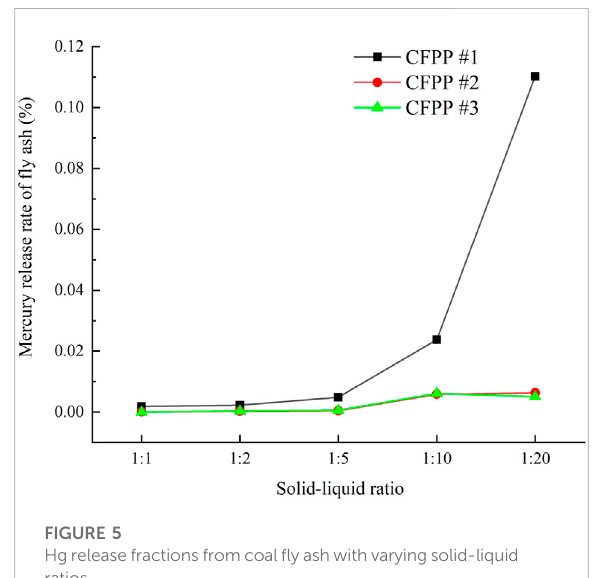
FIGURE 4 Leaching characteristics of Hg from coal fl y ash with varying pH and a constant solid-liquid ratio of 1:10.